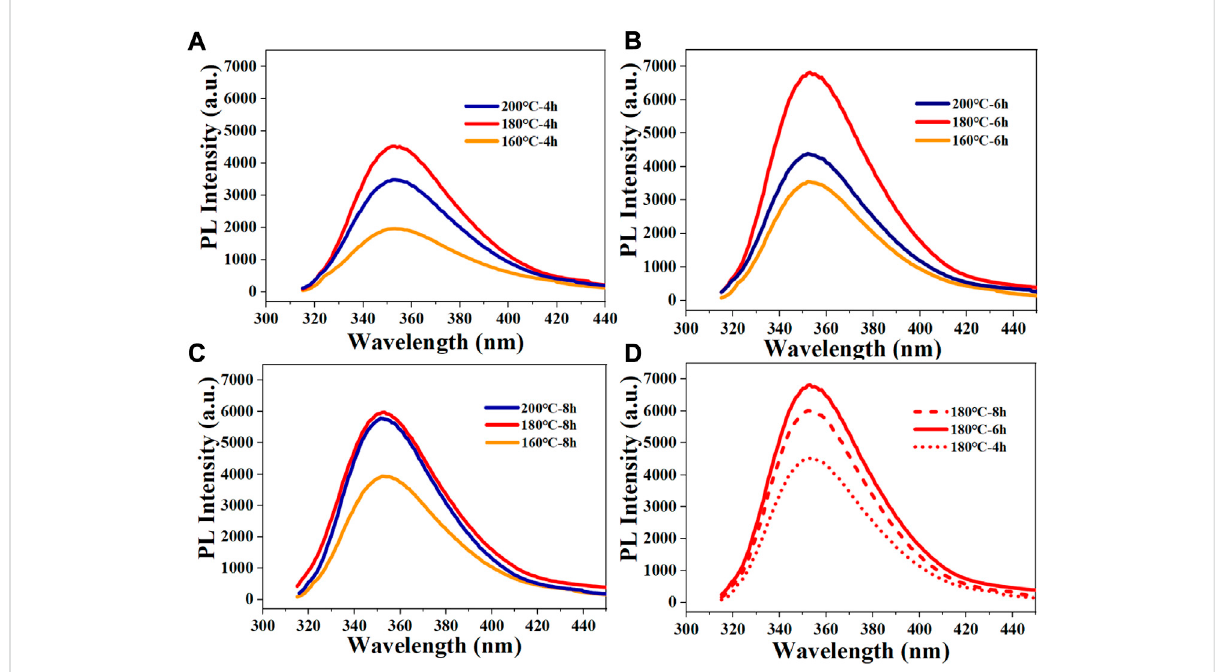
FIGURE 1 Fluorescence spectra of resultant CDs under different conditions: (A) different reaction temperatures with reaction time of 4 h; (B) different reaction temperatures with reaction time of 6 h; (C) different reaction temperatures with reaction time of 8 h; (D) different reaction times with reaction temperature of 180 °